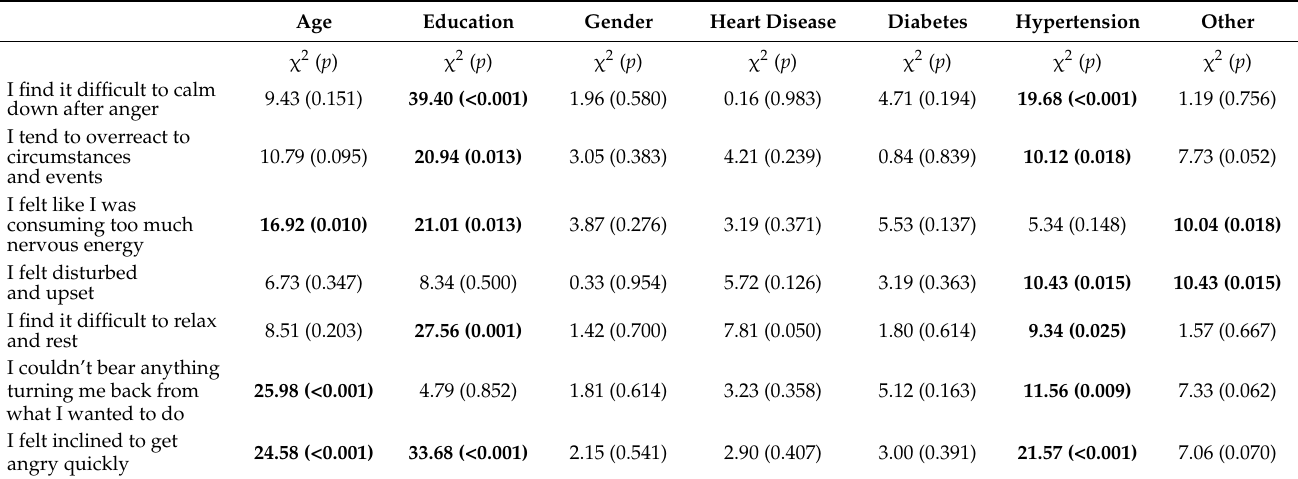
Table 7. Stress determinants to sex and medical conditions.